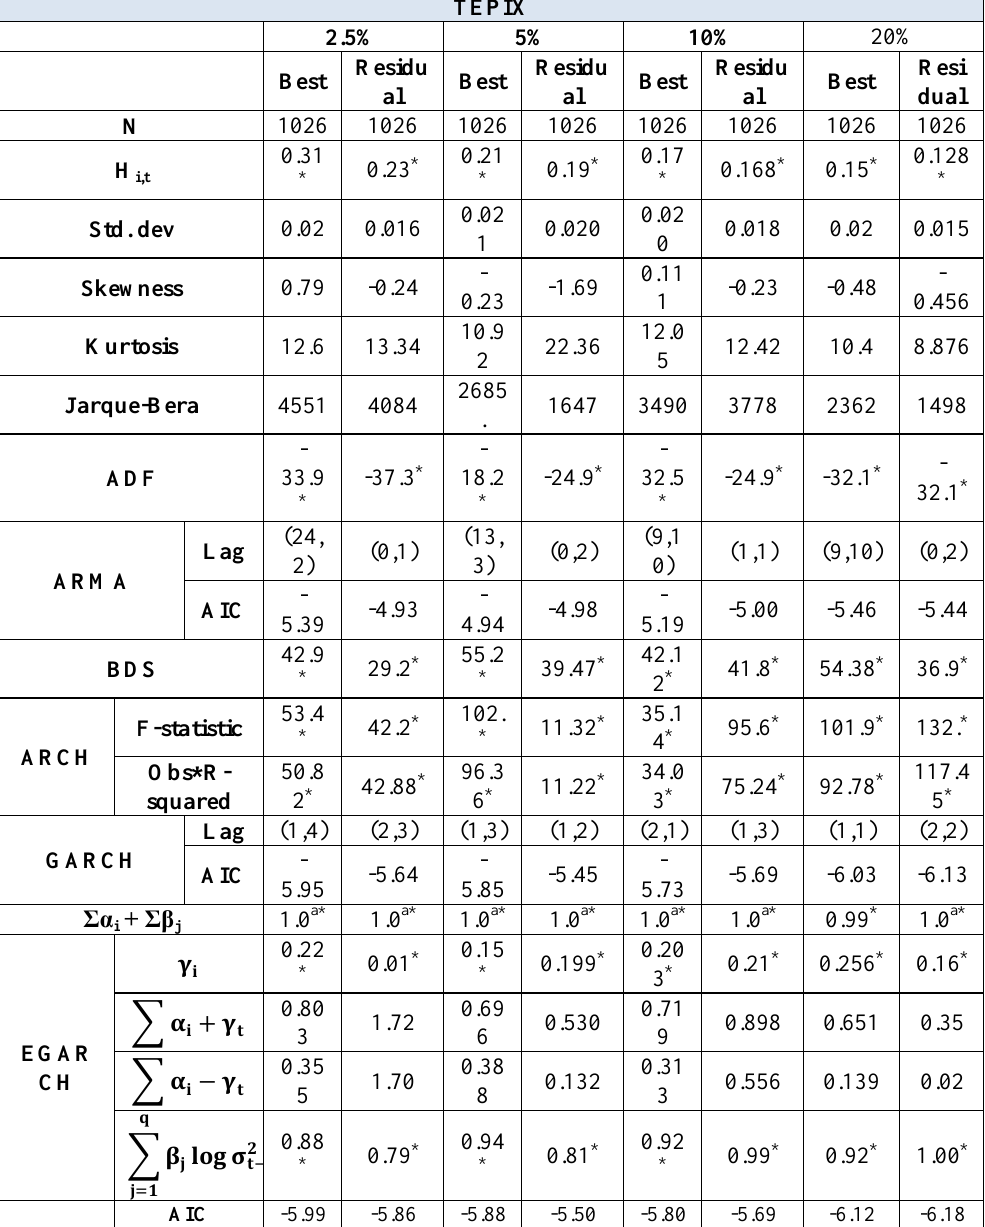
Table 2. Econometric statistics for the TEPIX price series estimated by